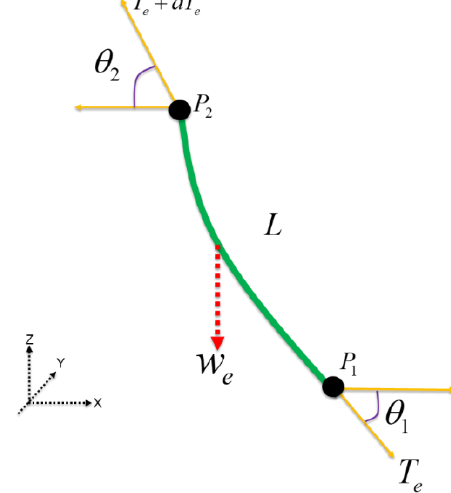
Figure 3. Tension distribution estimation model.